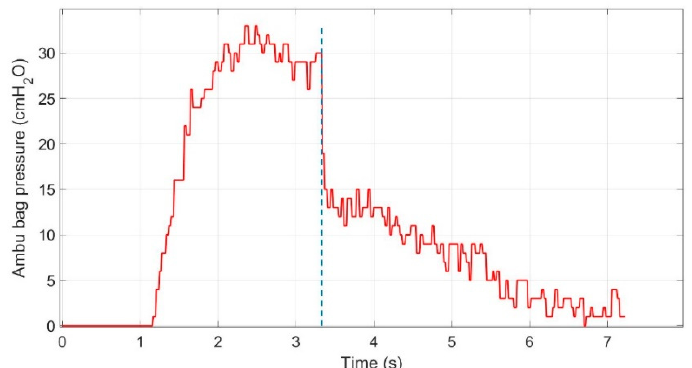
Figure 6. Rapid decrease of the pressure.